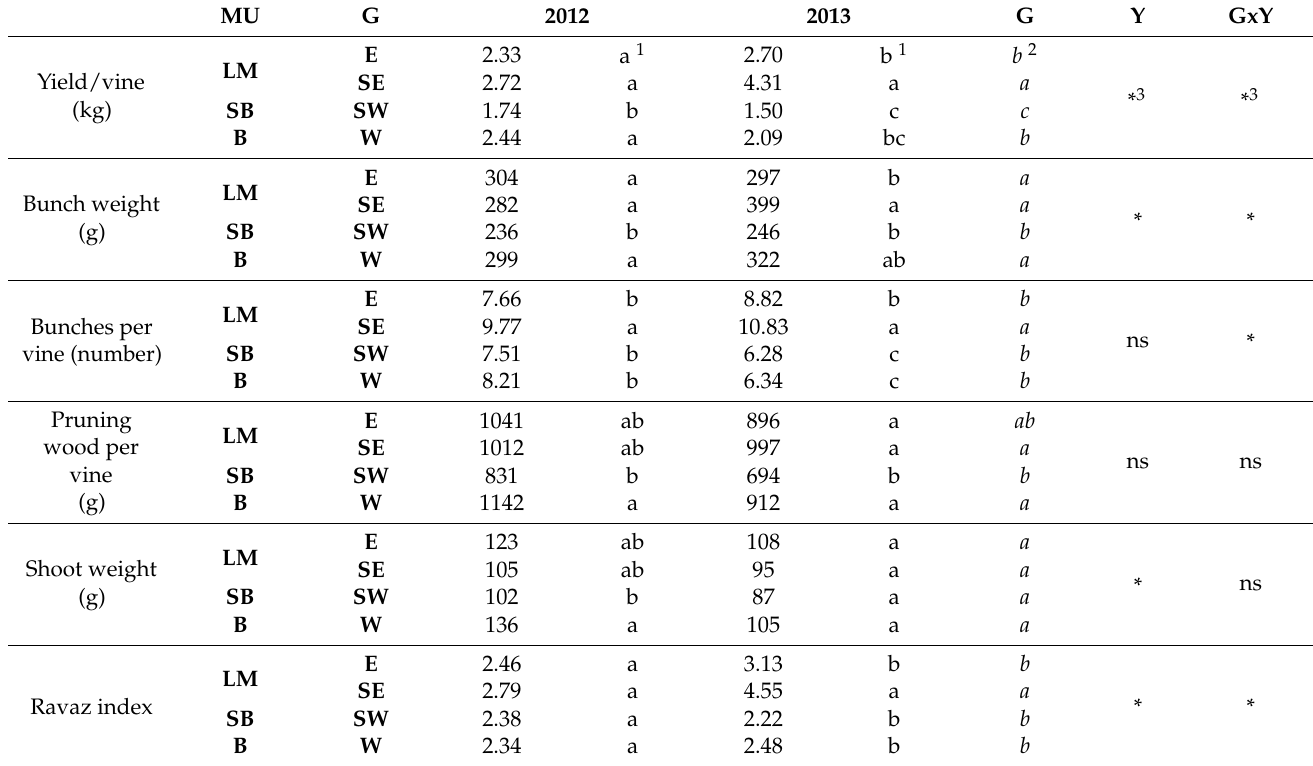
Table 4. Yield components assessed at harvest and vine vigor parameters assessed at winter pruning in 2012 and 2013. Data corresponds to the mean values of the vineyards belonging to each group (G): E = vineyards facing east, SE = vineyards facing south-east, SW = vineyards facing south-west, W = vineyards facing west. MU = mesoclimatic units, Y = year, G = group, GxY = interaction group x